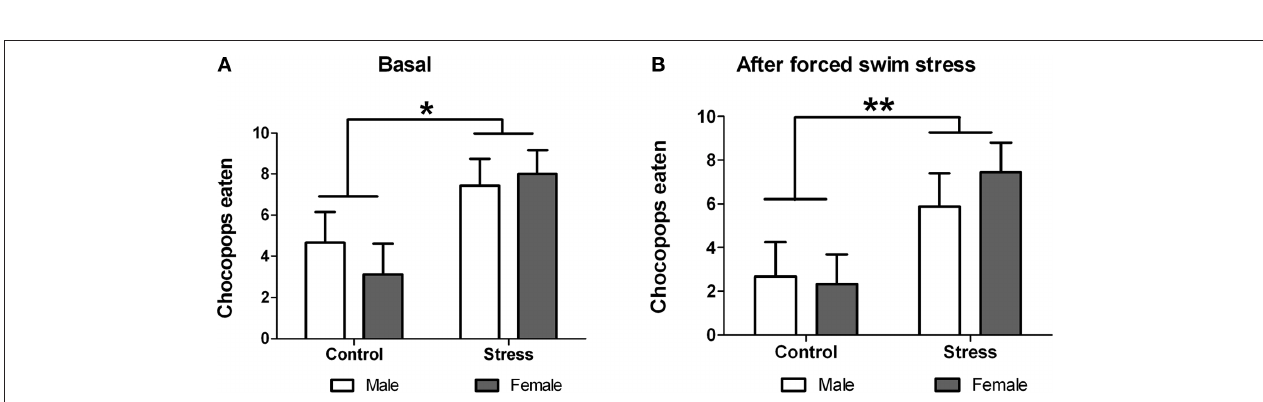
Figure 5 | effect of peri-pubertal stress on behavior at the forced-swim test. Mean (SEM) behavioral measures in the forced-swim test for male and female rats that underwent either peri-pubertal stress (Stress) or no stress (Control). (a) Time spent floating and (B) number of times floating. ## p < 0.01 sex effect.